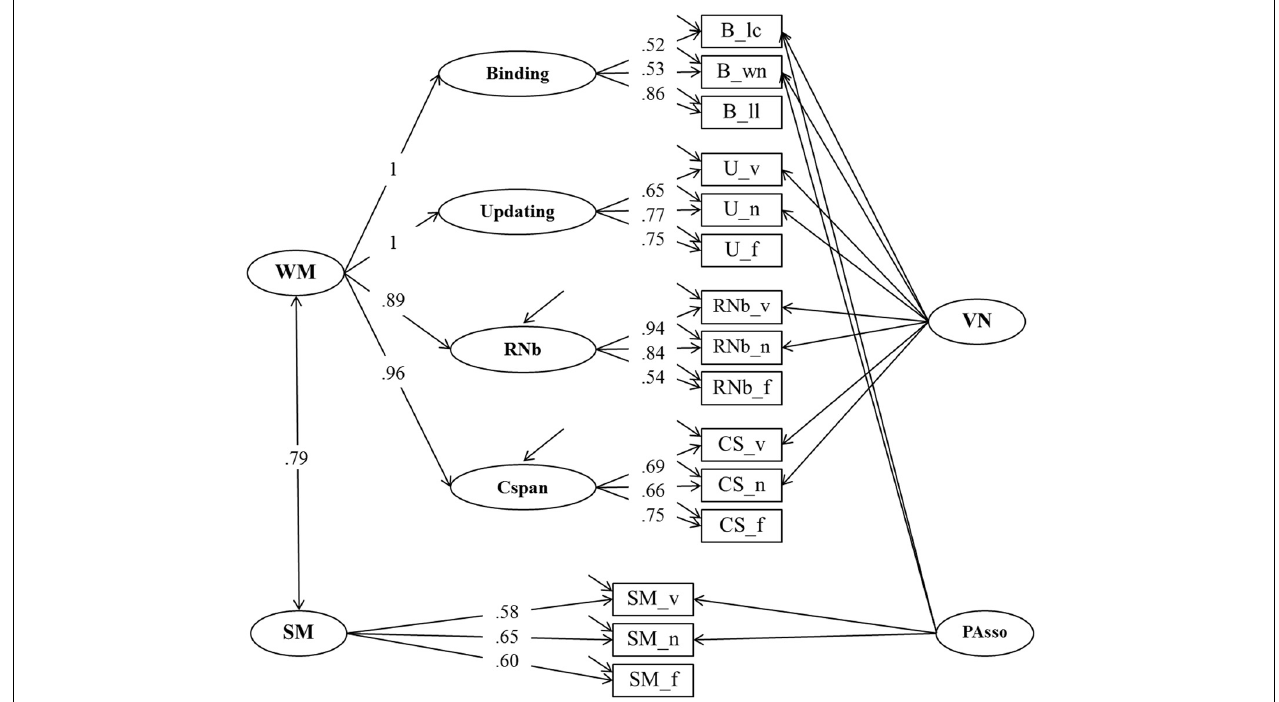
FIGURE 5 | Structural equation model of WMC and Secondary Memory (SM) (Model 3). The measurement model of WMC is identical with the one depicted in Figure 3 , postulating a higher order model for WMC with four first order factors: Binding, Updating, Recall 1-back (RNb) and Complex Span